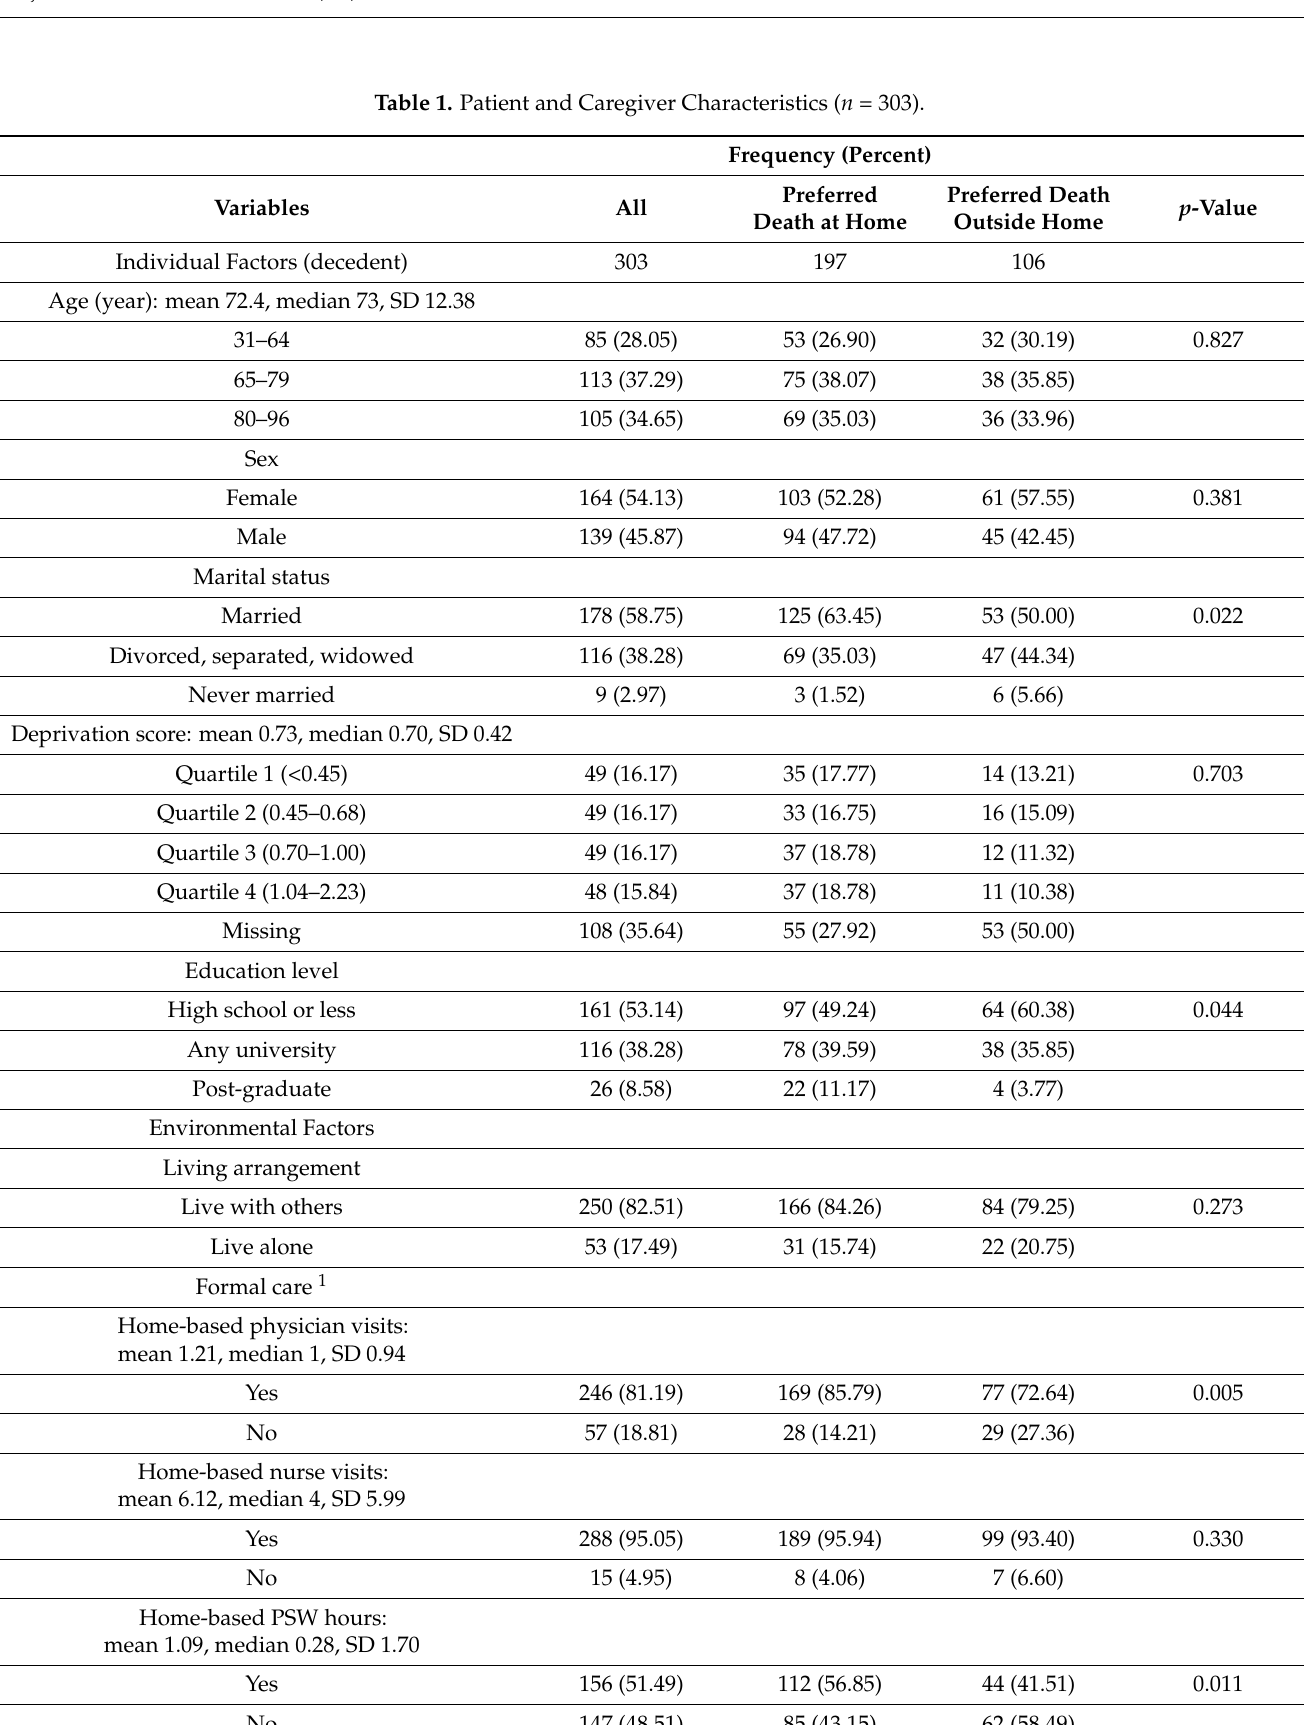
Table 1. Patient and Caregiver Characteristics ( n =